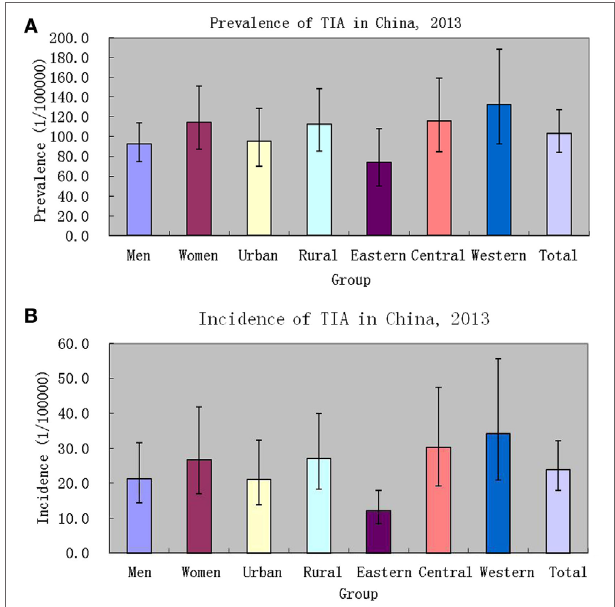
FigUre 3 | Prevalence [ (a) , 1/100,000 person*life time] and incidence [ (b) , 1/100,000 person*years] of transient ischemic attack (TIA) in China,